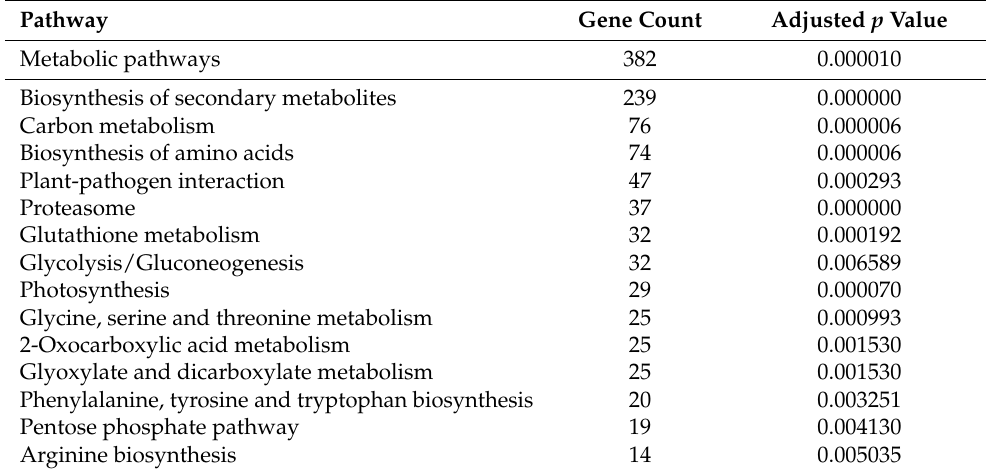
Table 2. The KEGG pathway enrichment of the total of differentially expressed genes